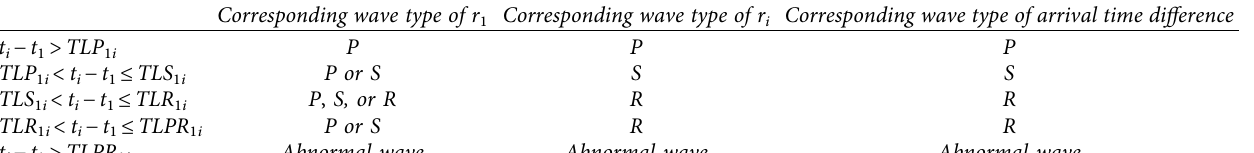
Table 1: Determination of wave velocity type.